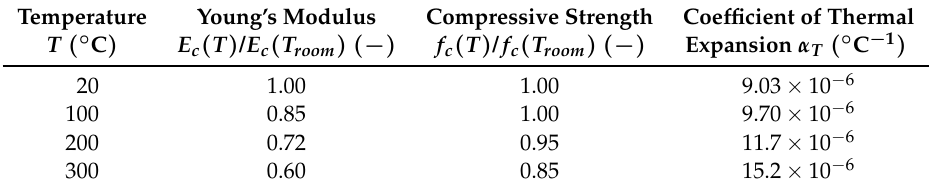
Table 6. Temperature-dependent thermoelastic properties of concrete.